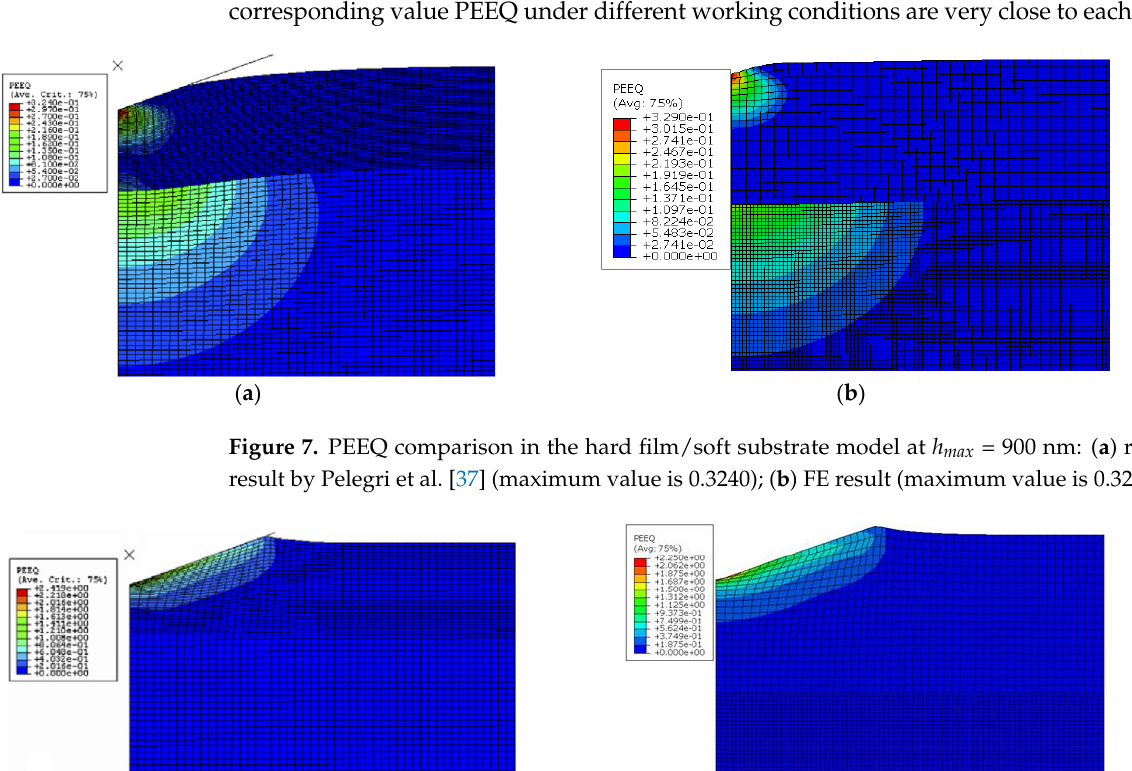
Figure 6. Stress deformation diagram for indentation depth of 0.3 μ m.